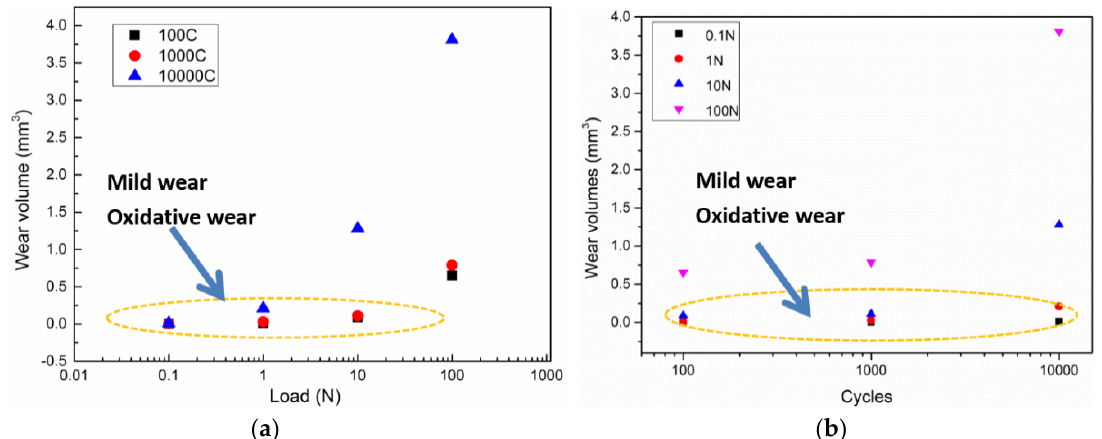
Figure 3. Wear volume (mm 3 ) of worn scars after the reciprocating sliding friction tests varied with ( a ) the load; ( b ) the cycles.